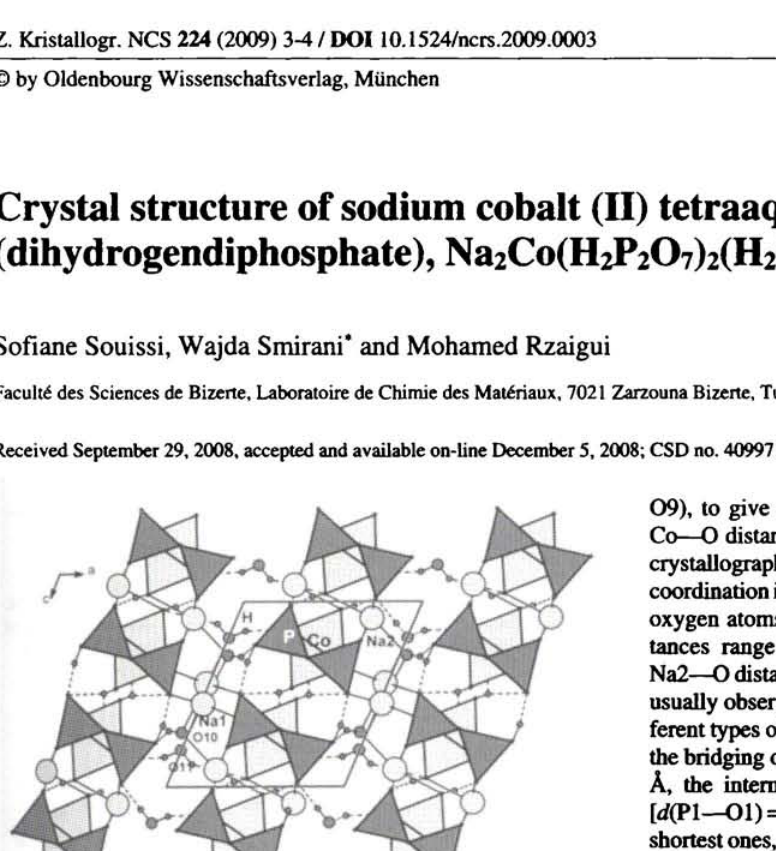
Table 1. Data collection and handling.